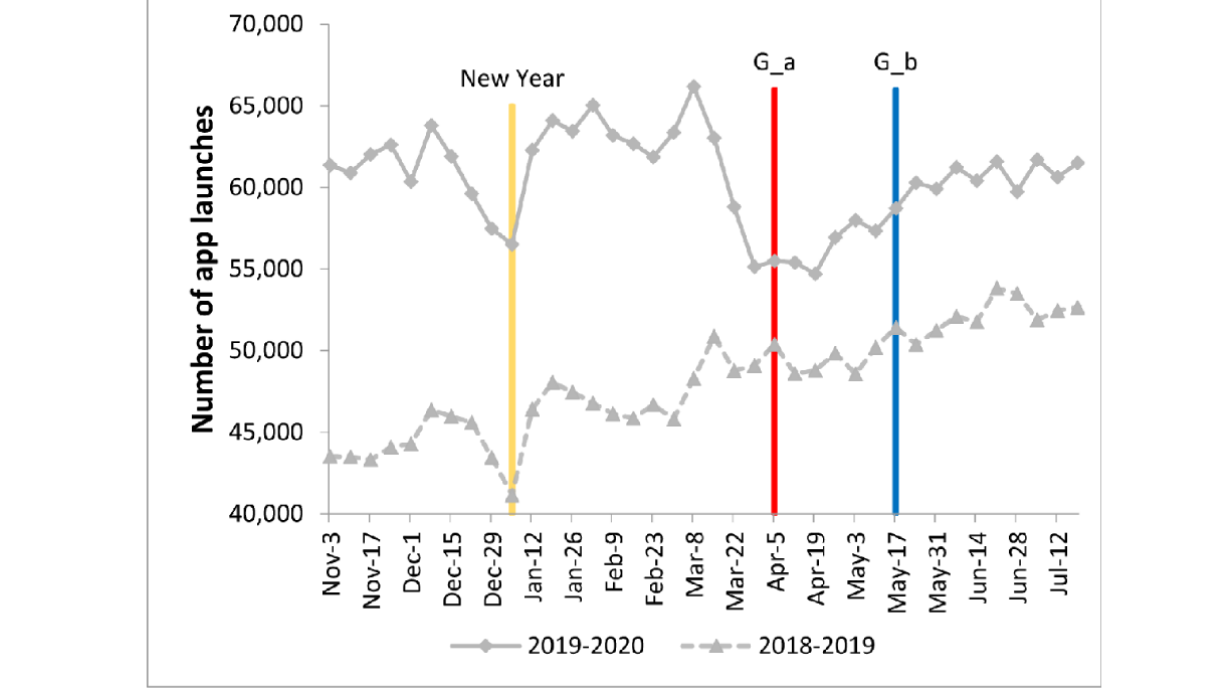
Figure 1. Weekly app launches (number of times of app usage) from November 2019 to July 2020, compared to the previous year’s data for the same duration (dotted line). For the curve representing November 2019 to July 2020, there are 2 troughs around new year’s day and COVID-19 lockdowns in April 2020. A corresponding trough near new year’s day 2019 is observed in the previous year’s curve, but there is no corresponding decline in April 2019. G_a: approximately one-third of the world's population is living with COVID-19 restrictions, G_b: some countries, including Spain, Iran, Italy, Denmark, Israel, Germany, New Zealand, and Thailand began to ease lockdown restrictions.